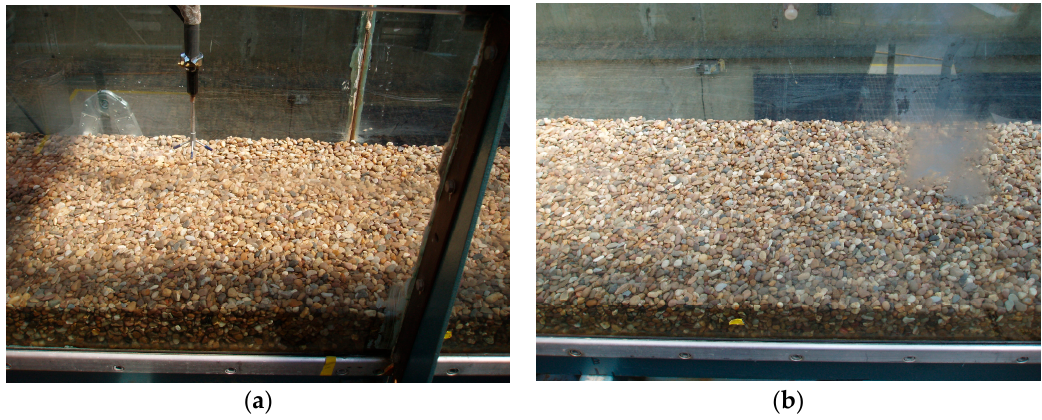
Figure 2 . Comparison of ( a ) water-worked bed and ( b ) experimentally prepared rough bed in lab flume.